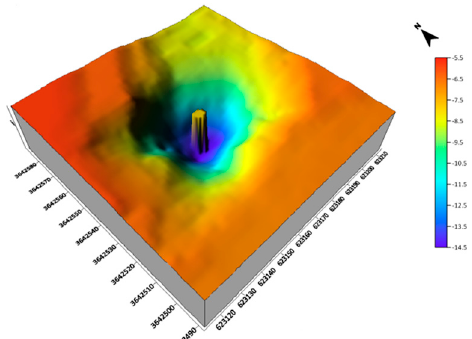
Figure 15. The measured scour condition around the monopole with D = 6 m. Table 7. Parameters of the 6 MW offshore turbine.